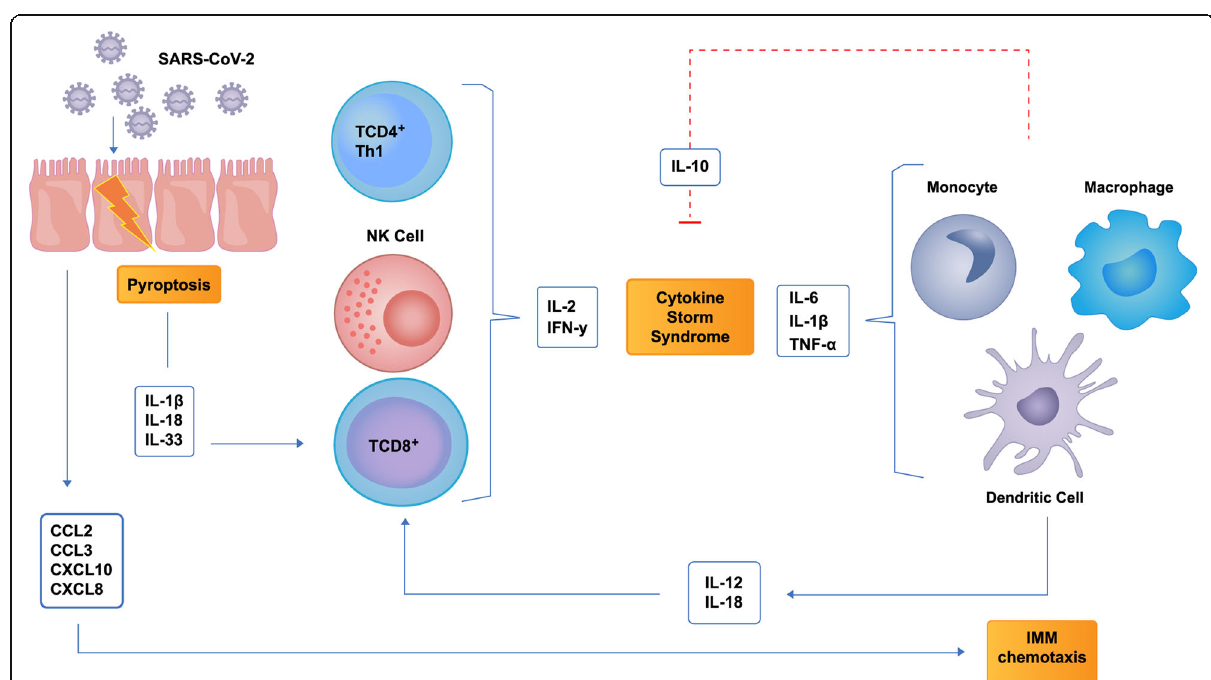
Fig. 3 Cytokine Storm from SARS-CoV-2. SARS-CoV-2 infection cause pyroptosis of alveolar epithelial cells (type II pneumocytes) leading to release of cytokines such as IL-1 ß, IL-18 and IL-33 (alarmins). In turn, IL-1ß stimulates a large amount of pro-inflammatory cytokines and IL-18 stimulates IFN- γ release by TCD8 + effector cells, Th1 lymphocytes and NK Cells. Endothelial and epithelial damaged cells also release chemokines such as CCL2, CCL3 and CXCL10 that attract myeloid mononuclear cells that release more inflammatory cytokines, creating a positive feedback loop. IL-10 is released as an inefficient attempt to suppress inflammatory